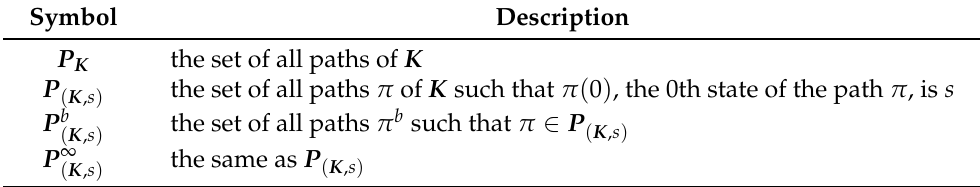
Table 2. Descriptions of path-set notations (or symbols), where b is a natural number.